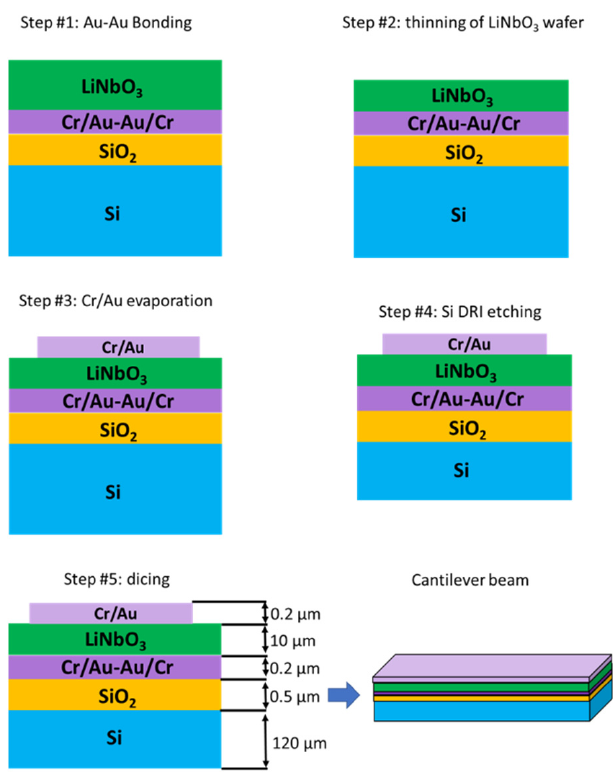
Figure 3. Microfabrication flow chart for cantilever beam development.